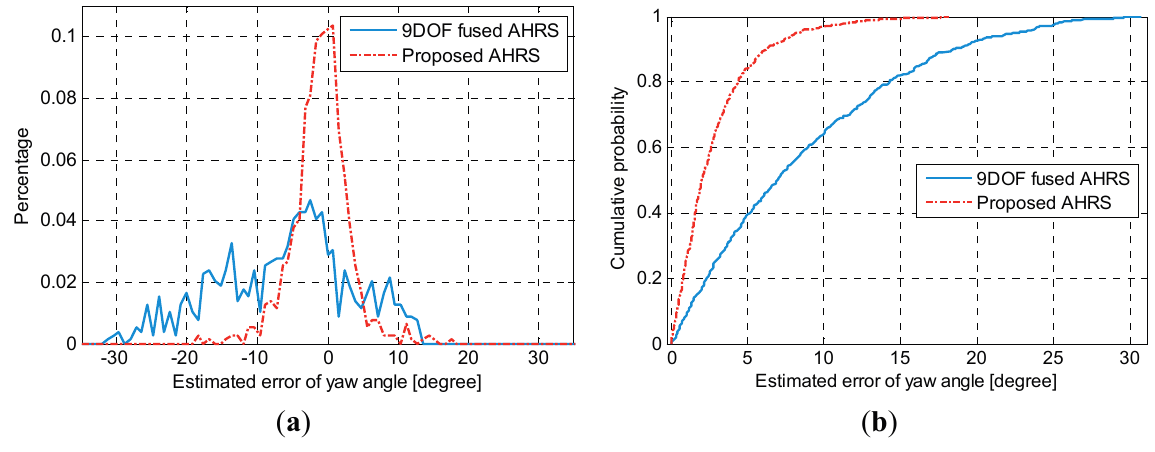
Figure 11. ( a ) Probability density functions of estimated errors in yaw angles; ( b ) Cumulative probability functions of estimated errors in yaw